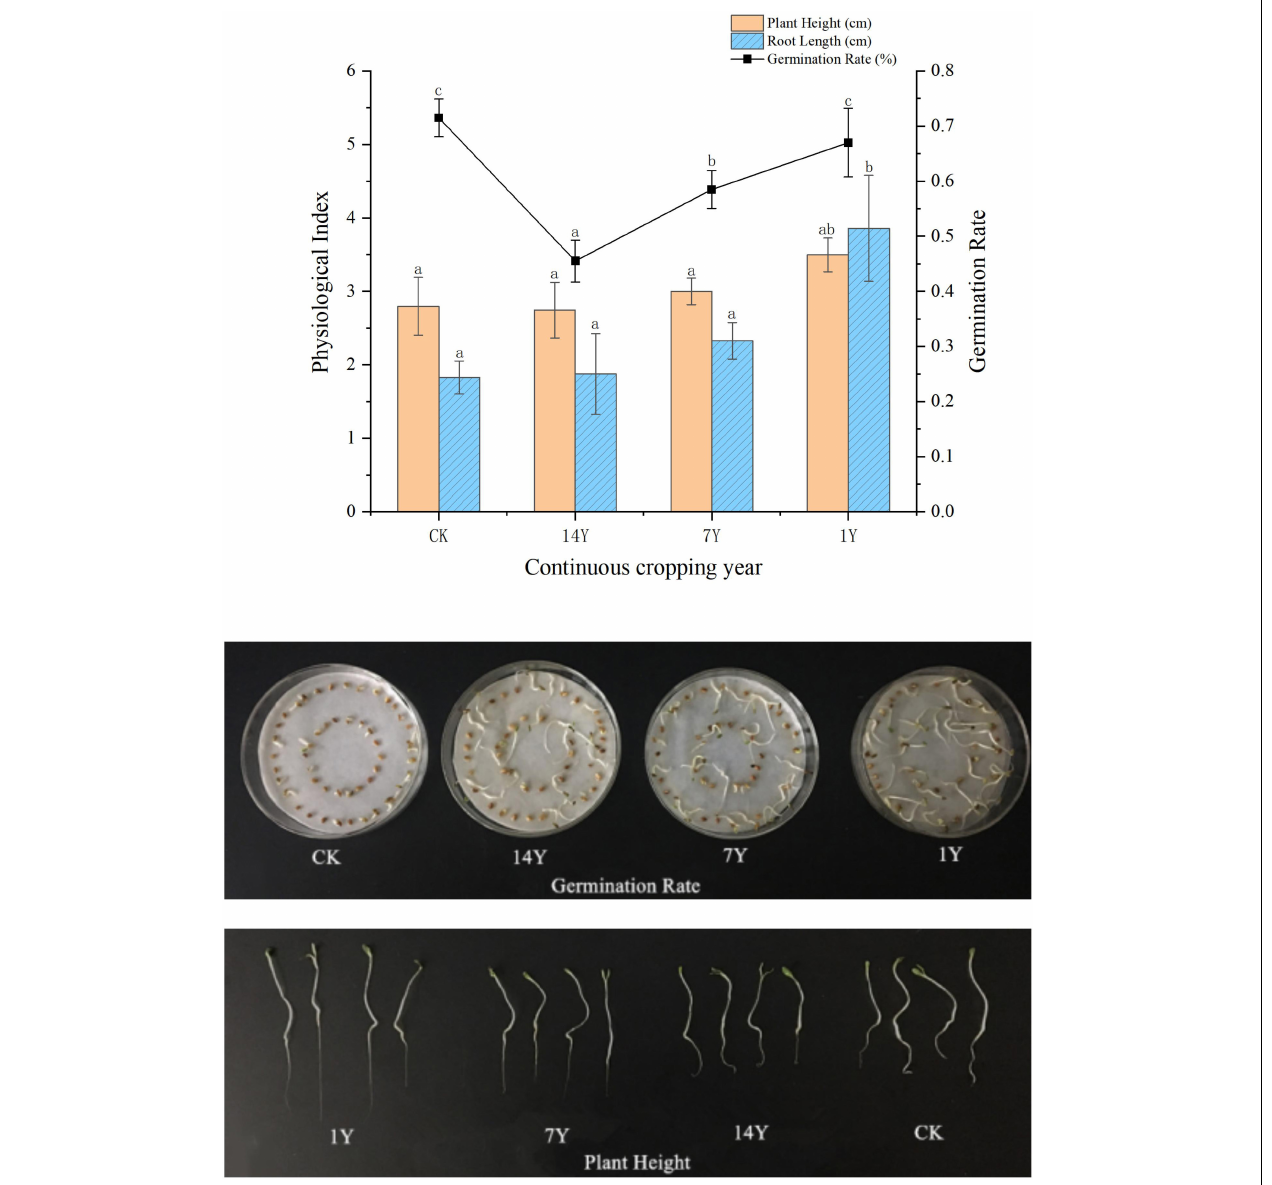
FIGURE 2 | Effects of rhizosphere soil extracts from fields with different years of alfalfa continuous cropping on alfalfa seed germination and seedling growth. Error bars indicate standard errors of the means of three repetitions. Different letters above the bars indicate significant difference according to Duncan’s multiple range test ( P =